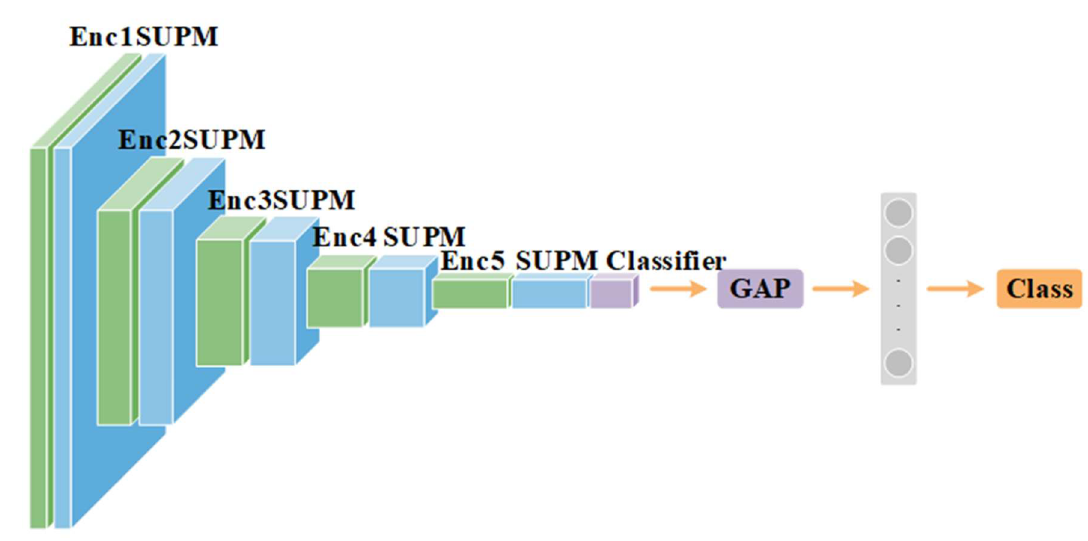
Figure 2. Backbone model of the proposed method.